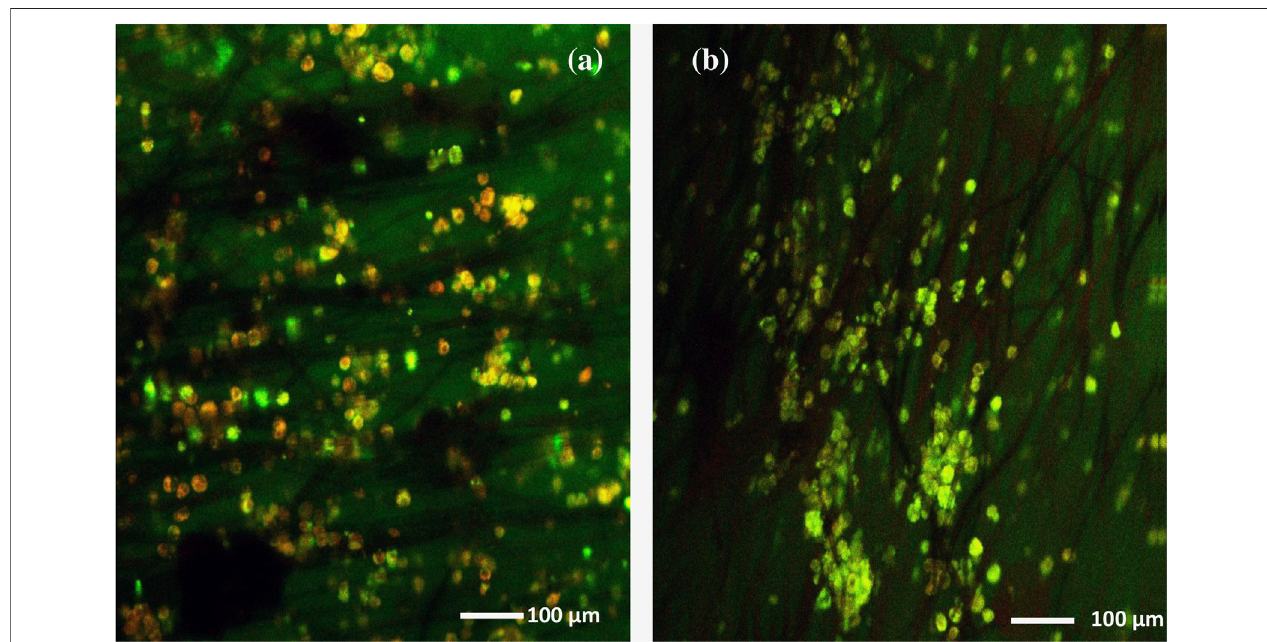
FIGURE 9 | Cell viability assay after 10 days of culture resulting images for (A) PHB and (B) PHB-PPyI scaffolds.